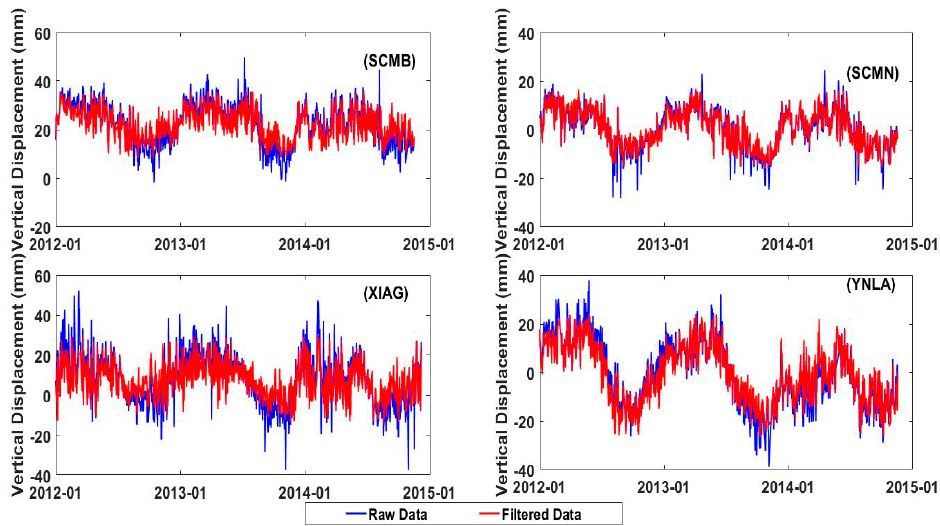
Figure 3. The comparison of the GPS height time series before (green) and after (red) filtering in the spectrum domain for four selected GPS stations (i.e., SCMB, SCMN, XIAG, and YNLA).